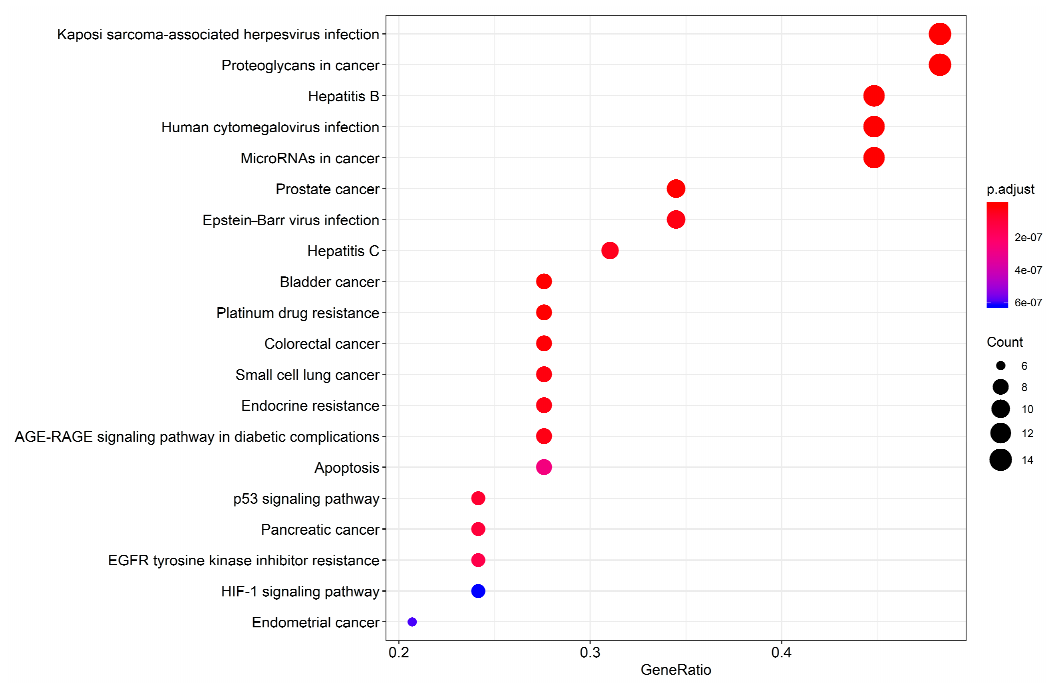
Figure 6. KEGG enrichment analysis for the 30 shared HDW compound targets/PCa-related targets. The color represents the different adjusted p -value < 0.05, while the size of circle represents the count.